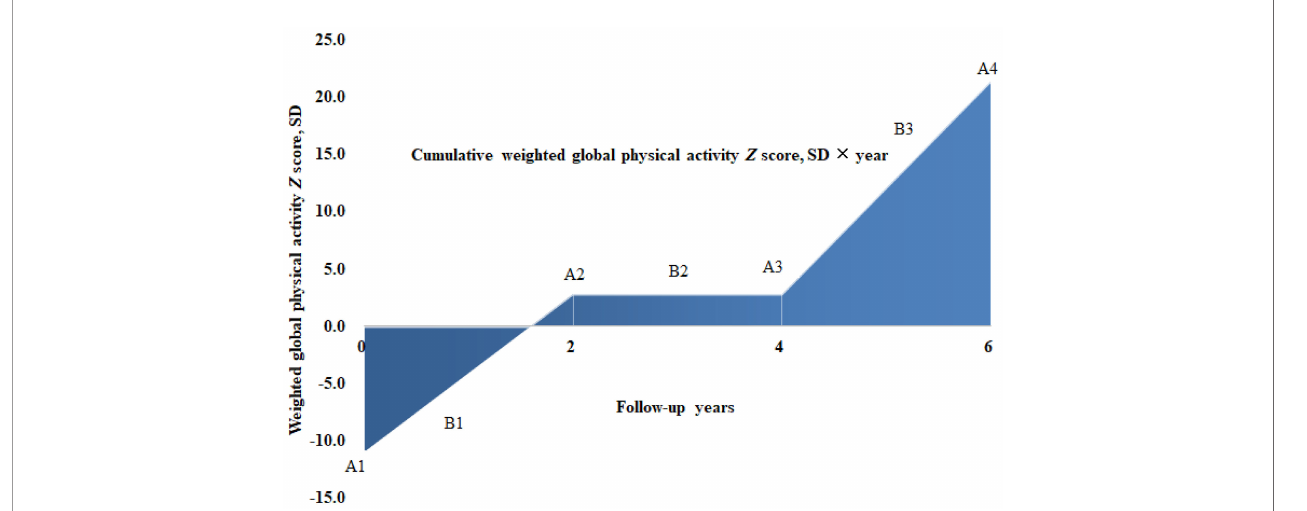
FIGURE 1 | Cumulative physical activity Z score calculation for 1 participant across 4 visits over a 6-year span in the ELSA. A1, A2, A3, A4 denotes weighted global physical activity Z score of 4 visits at wave 1 (year 2002), wave 2 (year 2004), wave 3 (year 2006) and wave 4 (year 2008), while B1, B2 and B3 indicates average activity Z score between consecutive visits of A1, A2, A3 and A4, respectively. According to trapezoid rule, the cumulative weighted activity Z score (SD × year), denoted as area under the curve in color blue, could be calculated as (B1 × 2y + B2 × 2y + B3 × 2y), with same approach applied to calculate cumulative mild, moderate and vigorous physical activity Z score over a 6-year span at the level of